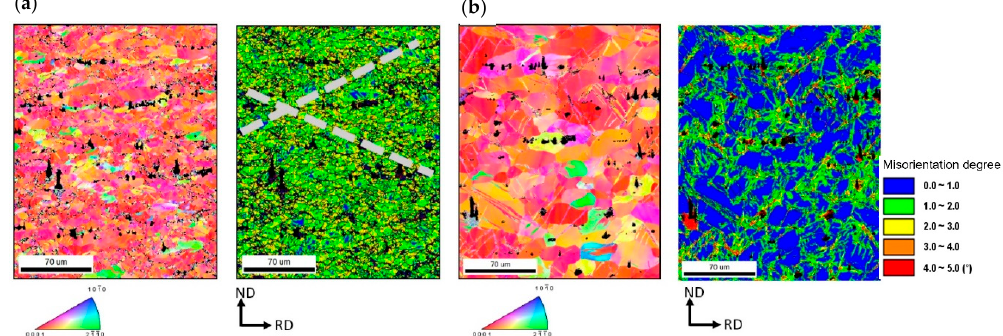
Figure 3. EBSD inverse pole figure maps and kernel average misorientation maps of the as-rolled sheets by ( a ) 450-inc and ( b ) 450-dec rolling schemes.